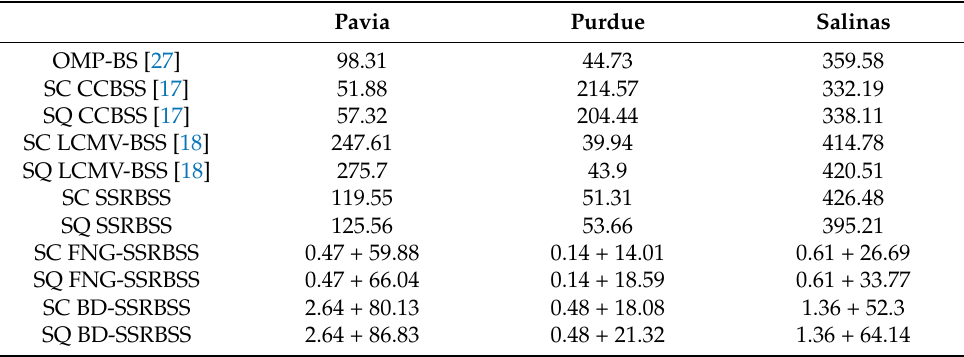
Table 12. Averaged computing time in seconds for various BS